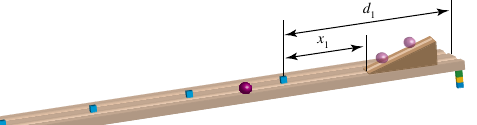
FIG. 3 (color online). The track is divided into four equal lengths. The motion of the ball is considered from the instant the ball reaches the bottom of the ramp. Distances are measured from each cube i both to the end of the track ( d i ) and to the bottom of the ramp ( x i ).